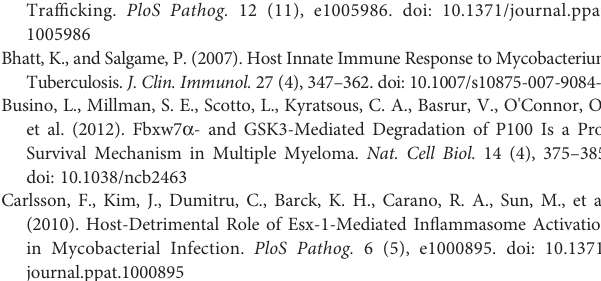
Supplementary Table 1 | Sequences the primers applied in quantitative real- time reverse transcriptase PCR. Supplementary Figure 1 | TGF- b and IL-10 expression in protein level when FBXW7 wassilencedin Raw264.7 cells. (A) FBXW7 was silencedinRaw264.7 cells with small interfering RNA; (B) TGF- b and IL-10 expression were detected with Western blot. Supplementary Figure 2 | FBXW7 was overexpressed with CRISPR/Cas9 in Raw264.7. Supplementary Presentation 1 | Publishing Agreement and Manuscript Cover